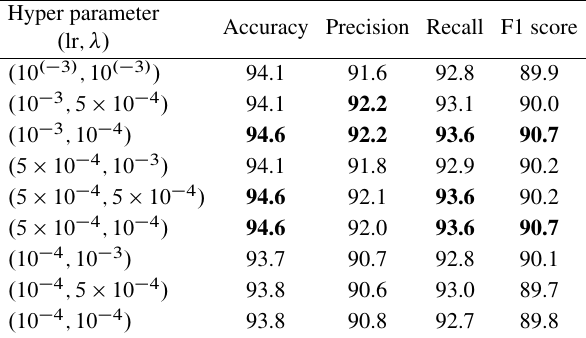
Table 2 Performance comparison of Multi-AFM on Education dataset when using different hyperparameter values.